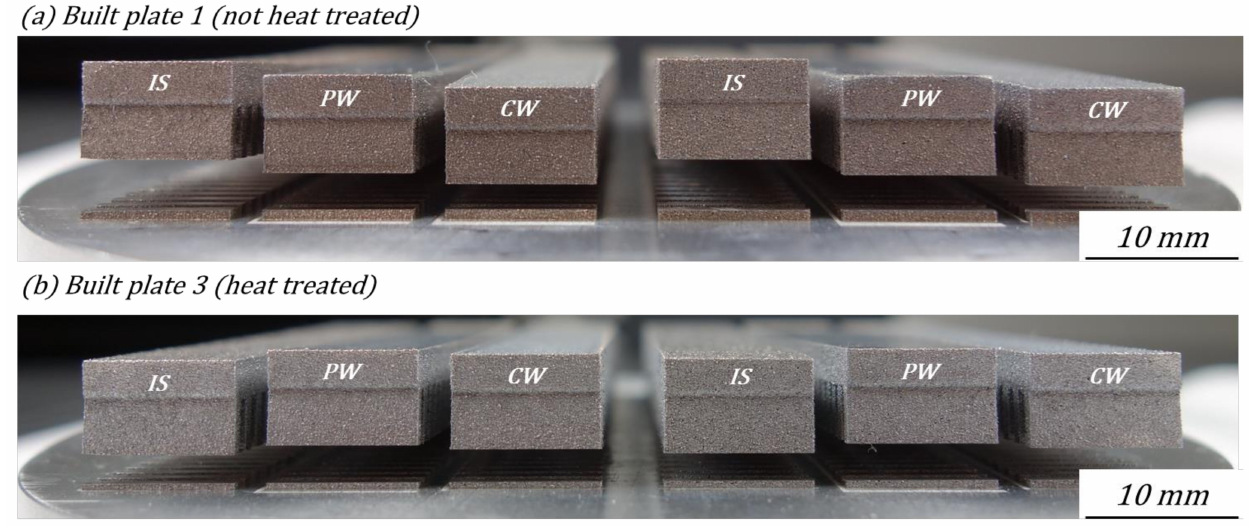
Figure 17. Distortion of the cantilevers depending on the laser polishing process, ( a ) without prior heat treatment, ( b ) with prior heat